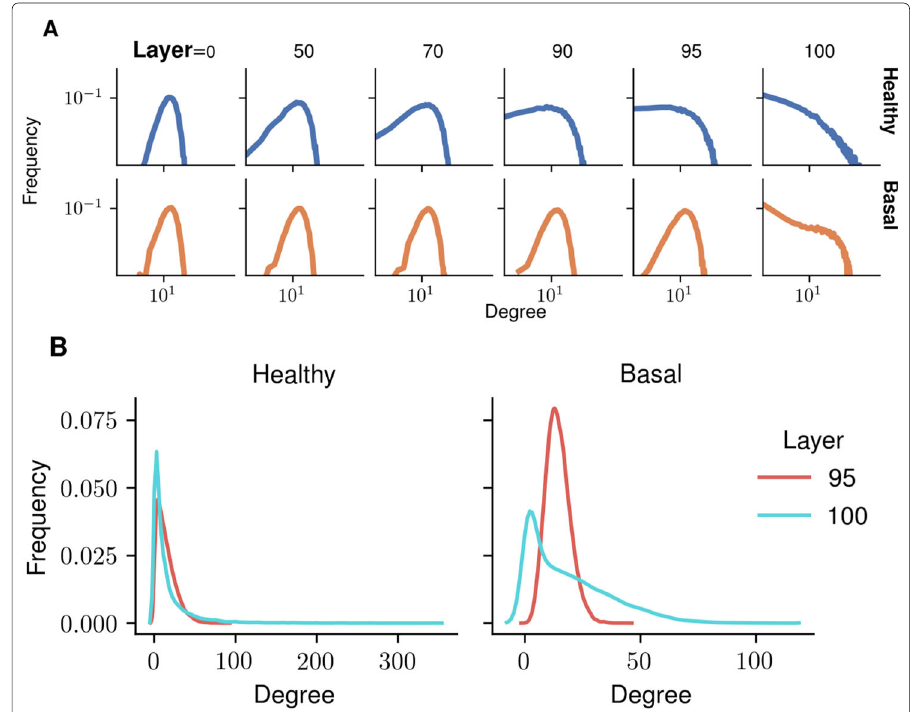
Fig. 4 a The evolution of degree distribution across 6 layers of the GCN of healthy and breast cancer (Basal-like) tissue. b Degree distribution of layer 100 (top layer) and layer 95 in both